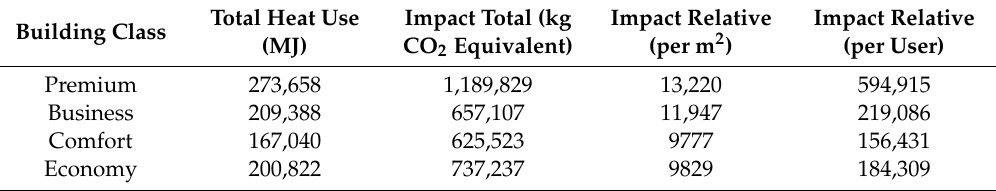
Table 2. Calculated values of CO 2